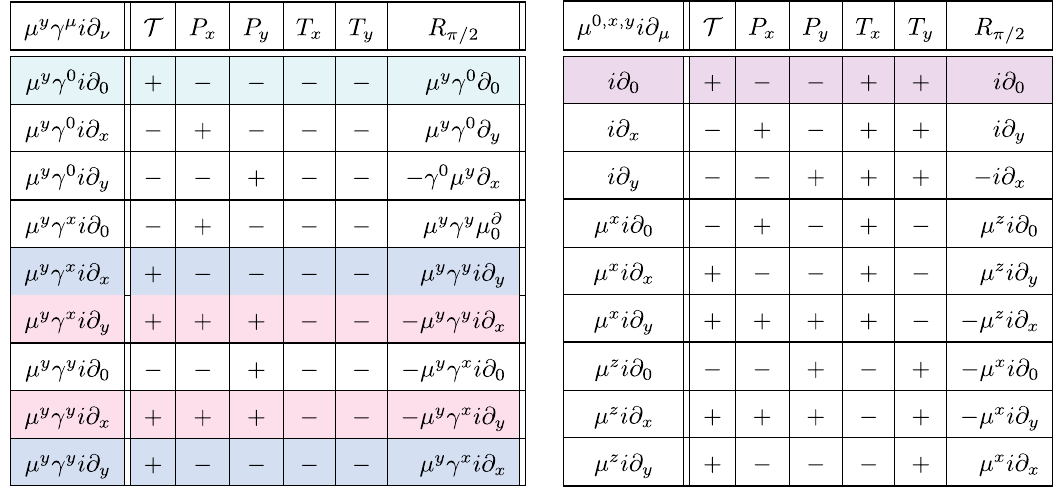
¯ Xi ∂ σ a ¯ X Γ j i ∂ σ a ¯ XT j γ μ i ∂ μ X Þ , tr ð μ X Þ , and tr ð ν X Þ , which do not = 2